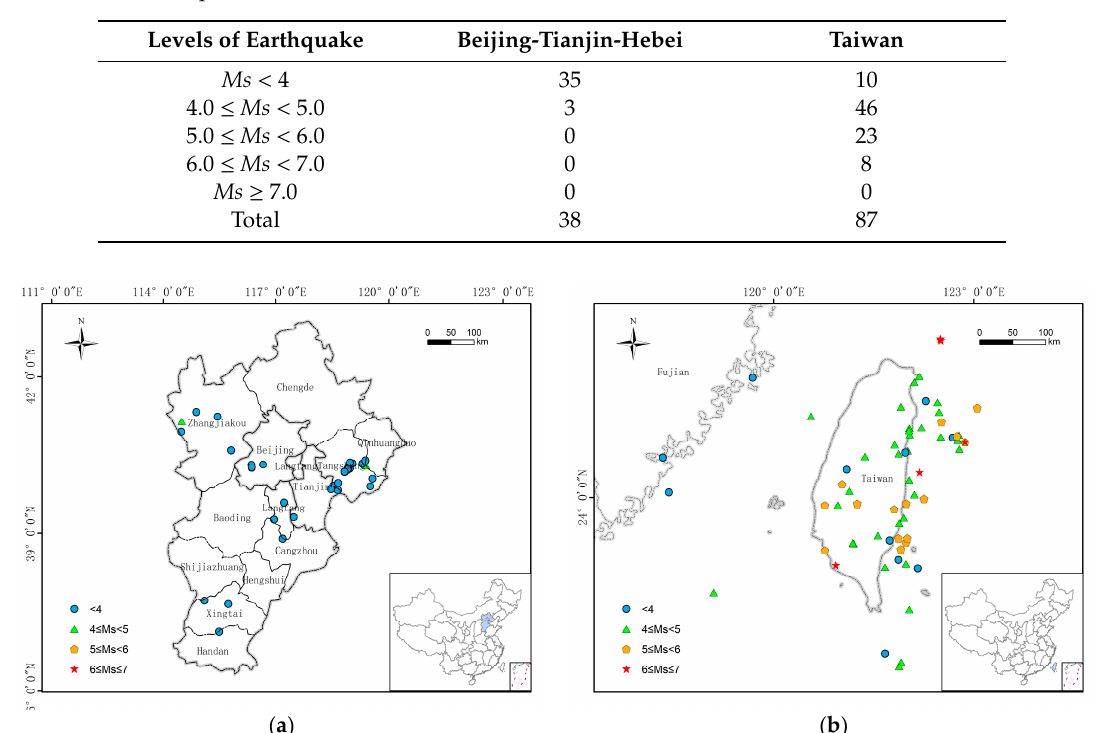
Figure 5. ( a ) Spatial distribution of news reported earthquake events in the Beijing-Tianjin-Hebei region, ( b ) spatial distribution of news reported earthquake events in Taiwan.